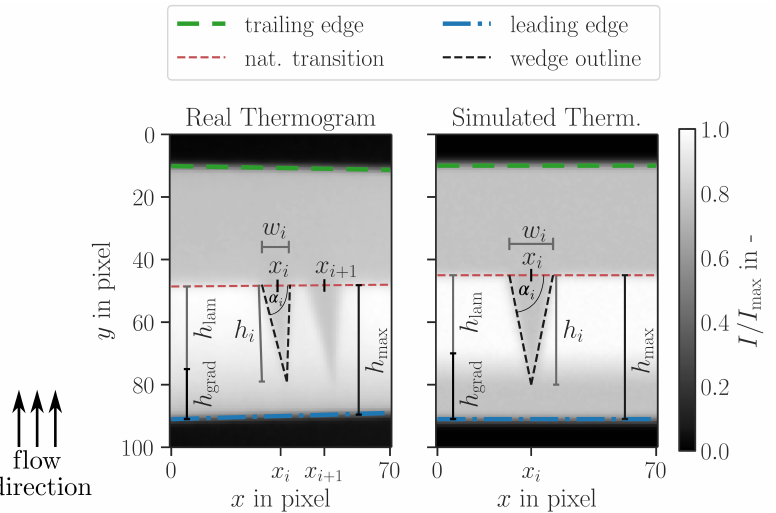
Figure 1. A real thermogram of a rotor blade of a wind turbine in operation with two turbulence wedges ( left ) and a simulated thermogram with one turbulence wedge ( right ). In this case, the rotor blade is warmer than the surrounding fluid, which means that the rotor blade is cooled by the boundary layer flow. The cooler the temperature, the lower the pixel intensity. Important characteristics of the thermograms are